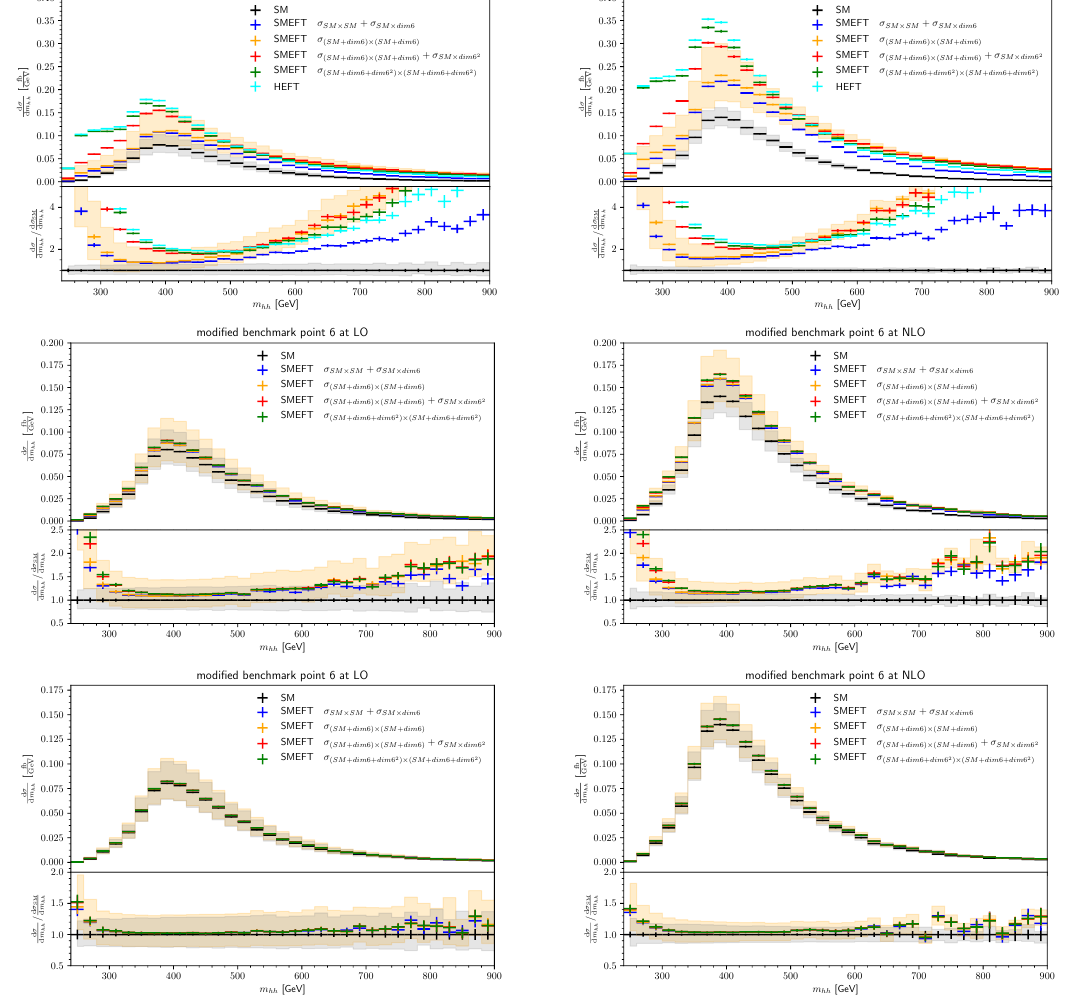
Figure 4 . Differential cross sections for the invariant mass m hh of the Higgs-boson pair for benchmark point 6 of table 2. Top row: Λ = 1 TeV, middle row: Λ = 2 TeV, bottom row: Λ = 4 TeV. Left: LO, right: